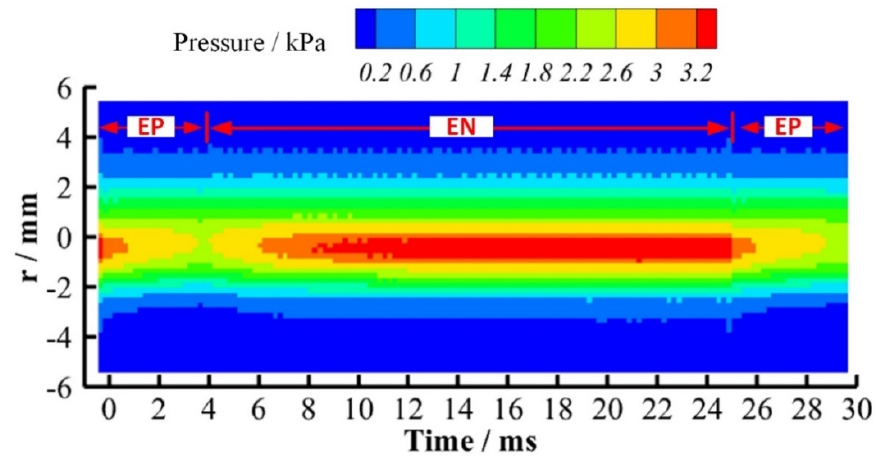
Figure 12. Radial distribution of plasma arc pressure as a function of elapsed time from the beginning of EP phase with the current of 150 A.